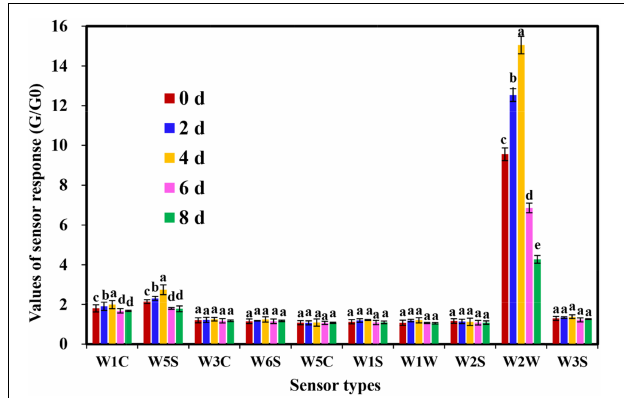
FIGURE 2 | Response values of electronic nose (E-nose) sensors for cut lily flowers during the postharvest process. The values (means ± SE) are the averages of three independent experiments ( n = 5). Bars not sharing the same letters on the same sensors indicate statistically significant differences using the Duncan’s multiple range test ( P <